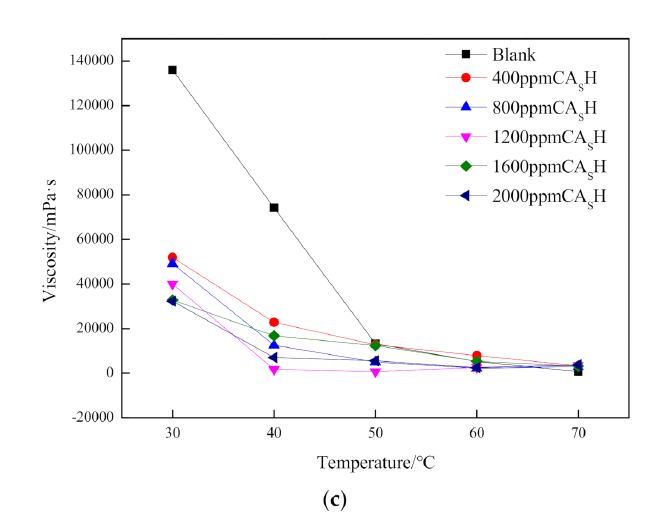
Figure 2. ( a ) Effect of CA C H on the viscosity of JHO crude oil; ( b ) effect of CA R H on the viscosity of JHO crude oil; ( c ) effect of CA S H on the viscosity of JHO crude oil. Furthermore, the performance of CA S H in XJO crude oil as a viscosity reducer was evaluated. Figure 3 depicts the apparent viscosity of crude oil at different doses as a function of temperature between 10 ◦ C and 30 ◦ C. Within a certain temperature range, CA S H have a significant effect on the viscosity of crude oil. The decrease of viscosity depends on the concentration and temperature of additives [18,19]. The results show that the viscosity of crude oil decreased to a lower level with the increase of additive dosage [20,21]. In Figure 3a, the viscosity decreased with the increase of temperature. When the temperature rose to 20 ◦ C, the change of viscosity was no longer obvious, and the viscosity reduction rate reached 74.7%. As shown in Figure 3b, the viscosity did not change significantly at 10 ◦ C. However, with the increase of temperature, the viscosity decreased continuously. When the temperature reached 20 ◦ C, the change of viscosity was no longer obvious, and the viscosity reduction rate reached 72.6%. In Figure 3c, the viscosity of crude oil (XJO) decreased obviously at 15 ◦ C and the viscosity reduction rate reached 67.8%. When the temperature reached 20 ◦ C, the change of viscosity was no longer obvious. When the temperature rose continuously, the viscosity of XJO crude oil did not change significantly.